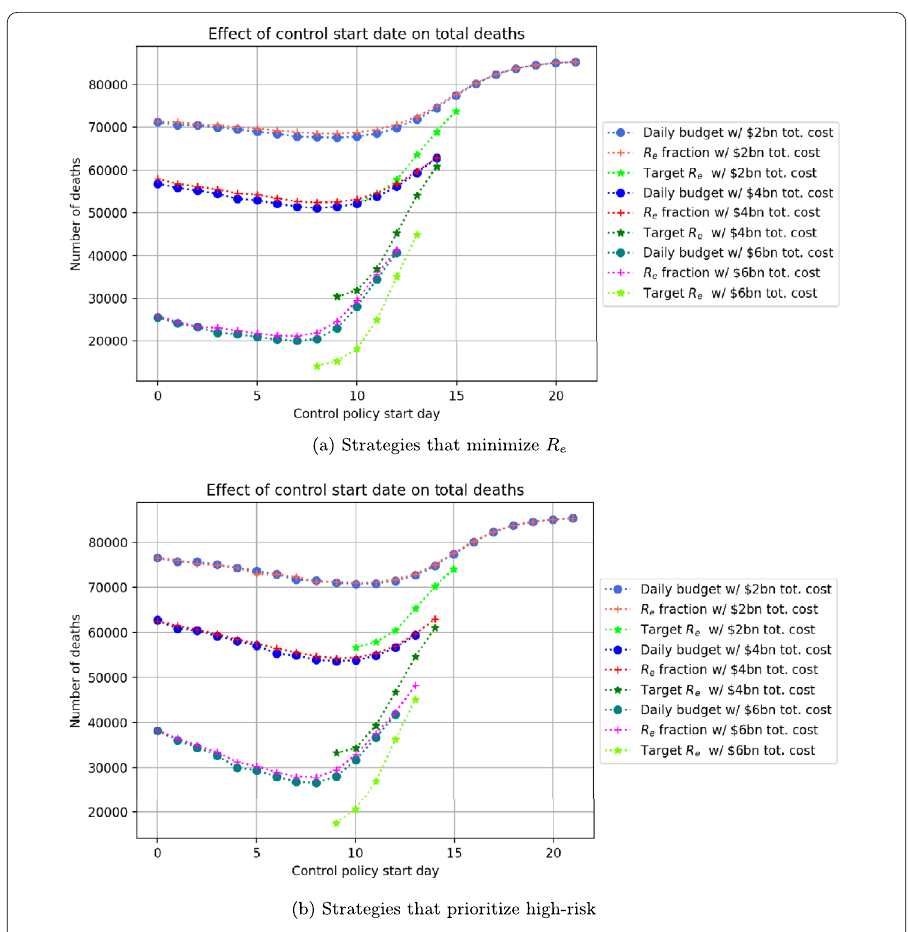
Figure 15 Number of the deaths obtained from different control strategy types depending on the control start day, for different budget